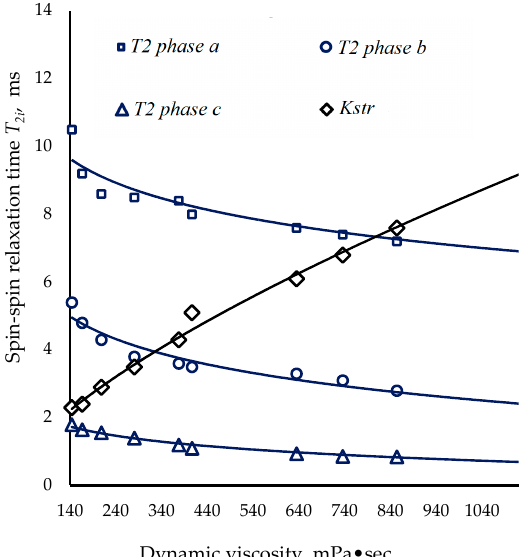
Figure 6. Spin–spin relaxation time T 2 i vs. dynamic viscosity of HRO oxidation products. For a quantitative assessment of the mobility of the components of bitumen and its oxidation products (HC, resins and asphaltenes) based on the obtained NMR parameters, an auxiliary coefficient K str (8) was proposed, reflecting the mass ratio of each of the phases (i) with their spin–spin relaxation time T 2 i . For the oxidation products of HRO, the proton concentrations are associated with spin–spin relaxation by an inverse relationship: